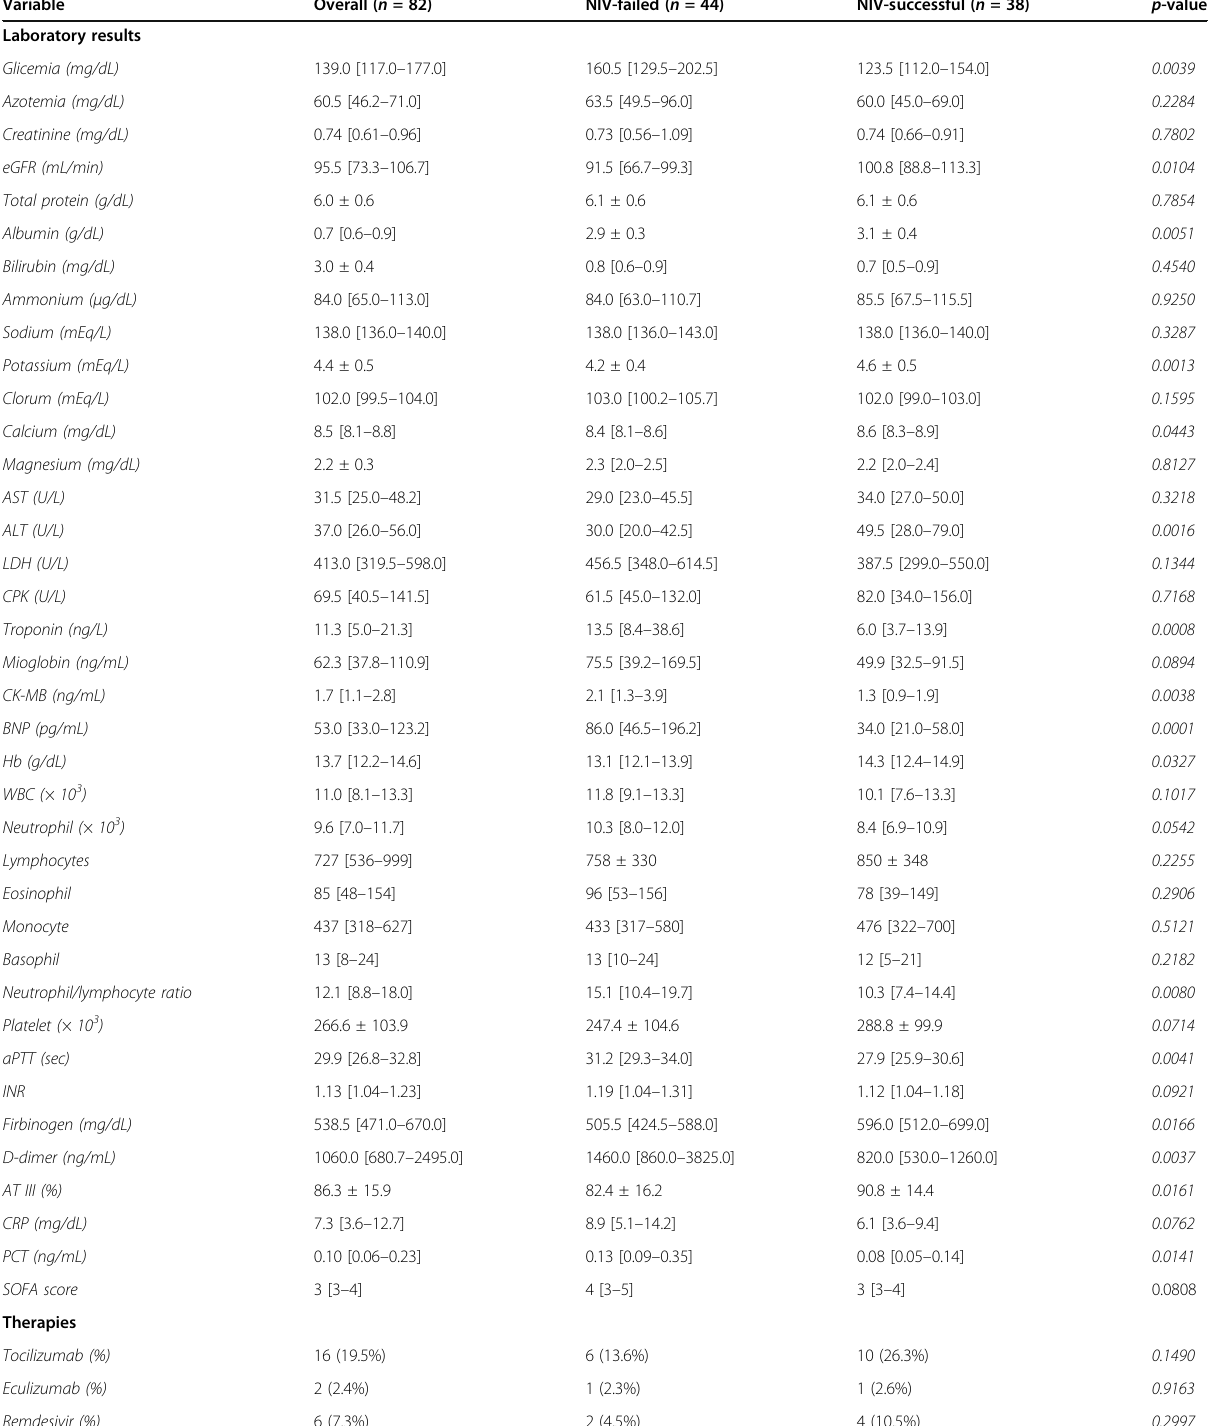
Table 3 NIV-failed vs NIV-successful groups: laboratory findings and therapies statistical